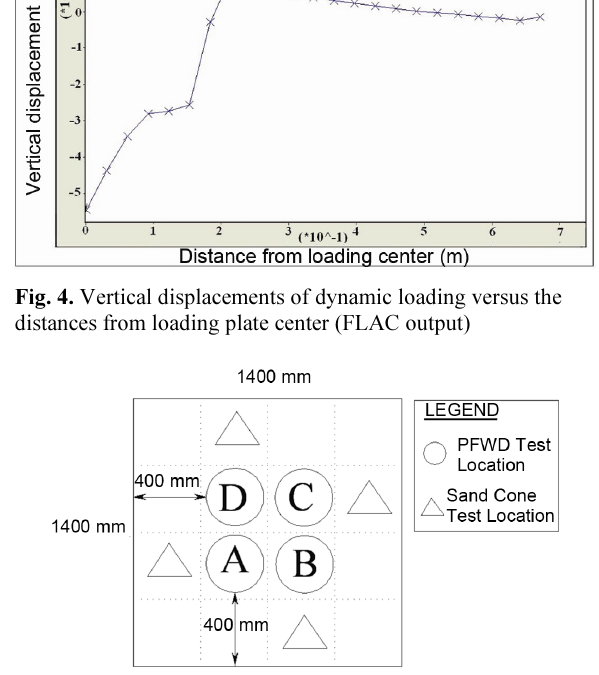
Fig. 5. Layout of the PFWD and sand cone tests in laboratory box